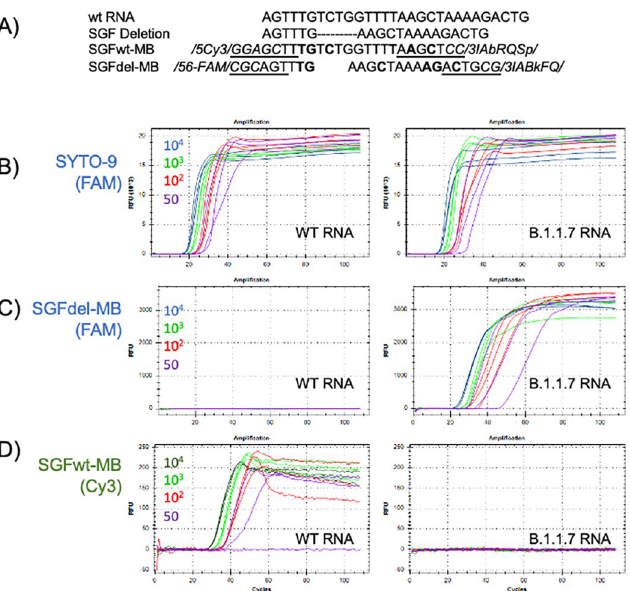
Fig 2. Detection of target RNAs by SGFwt and SGFdel molecular beacons. (A) Sequence comparison for wt, SGF deletion, SGFwt-MB and SGFdel-MB. Dashes: bases deleted in SGF deletion; Bold: LNA base; Underlined: stem region; Italics: non-target sequence, attached fluorophores and quenchers. LAMP reactions with either WT RNA (left panels) or B.1.1.7 RNA (right panels) in the presence of (B) SYTO-9, (C) SGFdel-MB, or (D) SGFwt-MB. The primer set amplifies both the wt and B.1.1.7 RNA with similar efficiency as detected with SYTO-9 (B). When beacon was added as a reporter, both SGFdel-MB (C) and SGFwt-MB (D) detected only their intended template RNAs from 50– 10,000